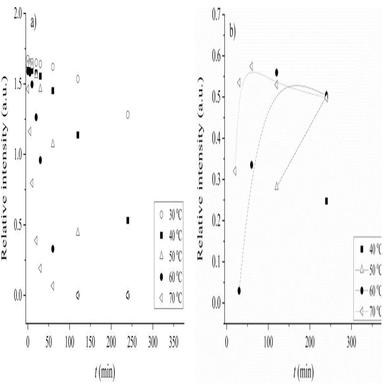
Relative intensity of deconvoluted peak during the reaction time at different temperatures at λmax values of: a) 257 nm and b) 231 nm.